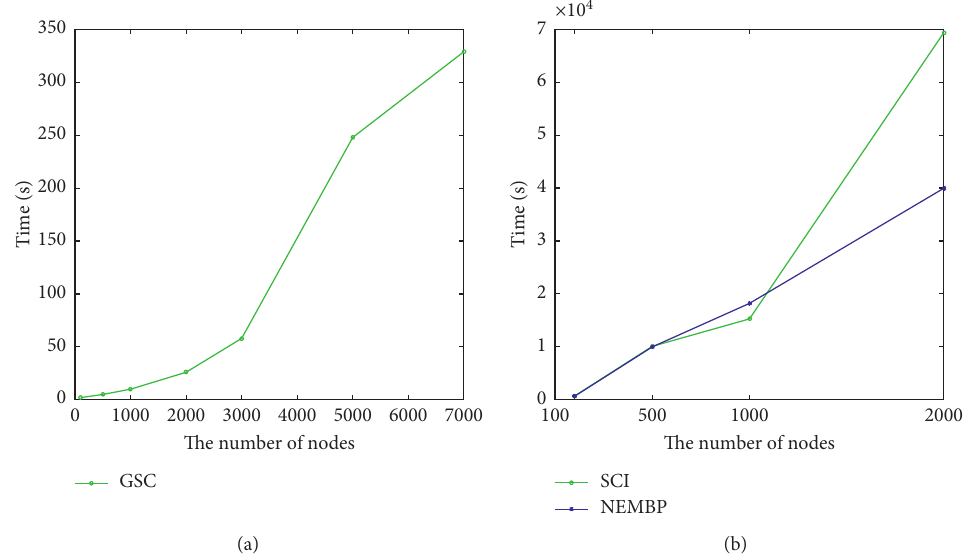
Figure 8: The running time on synthetic networks: (a) GSC on Synthetic networks with the change of nodes from 100 to 7000; (b) NEMBP and SCI on Synthetic networks with the change of nodes from 100 to